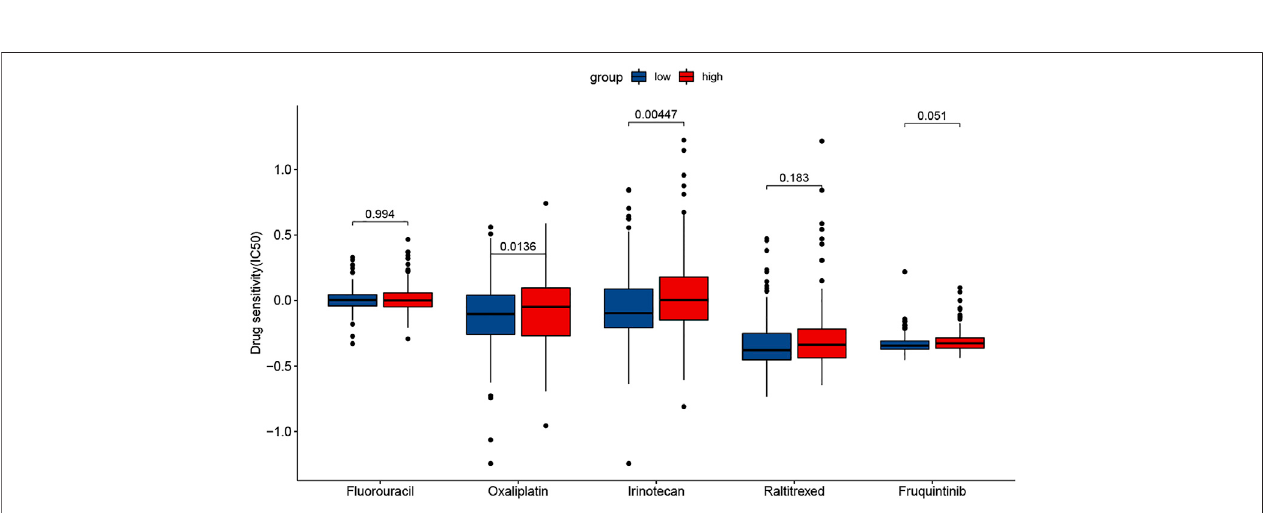
Frontiers in Genetics |